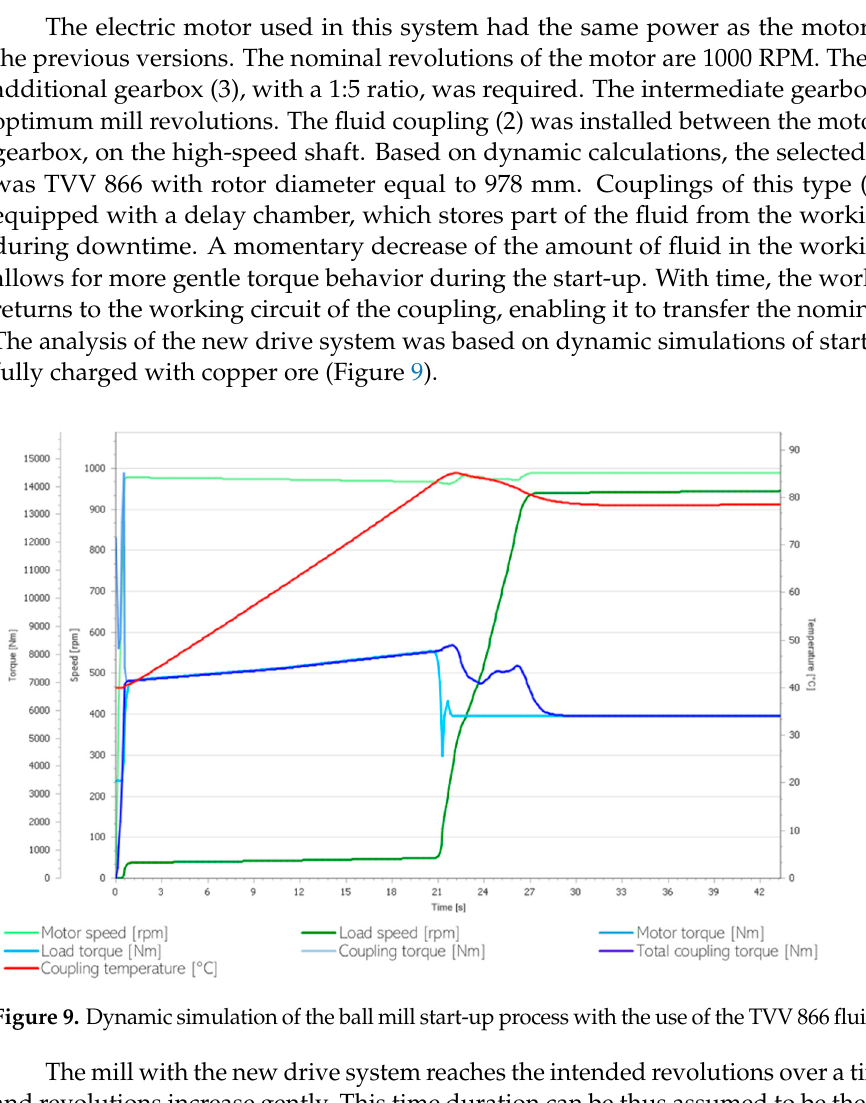
Figure 8. Schematic diagram of the drive system allowing the use of a fluid coupling for mill start-up: 1—asynchronous motor 630 kW 1000 RPM, 2—fluid coupling, 3—gearbox, 4—ball mill.